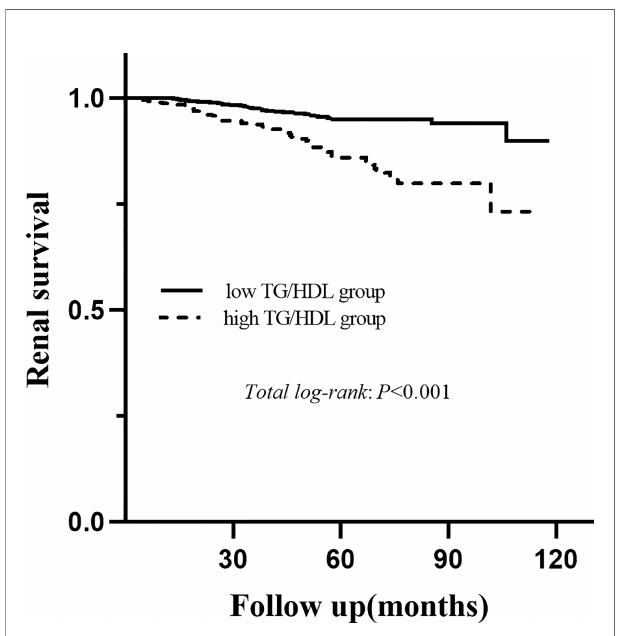
FIGURE 2 | Kaplan-Meier analysis for the endpoint of ESRD strati fi ed by the cutoff point of the